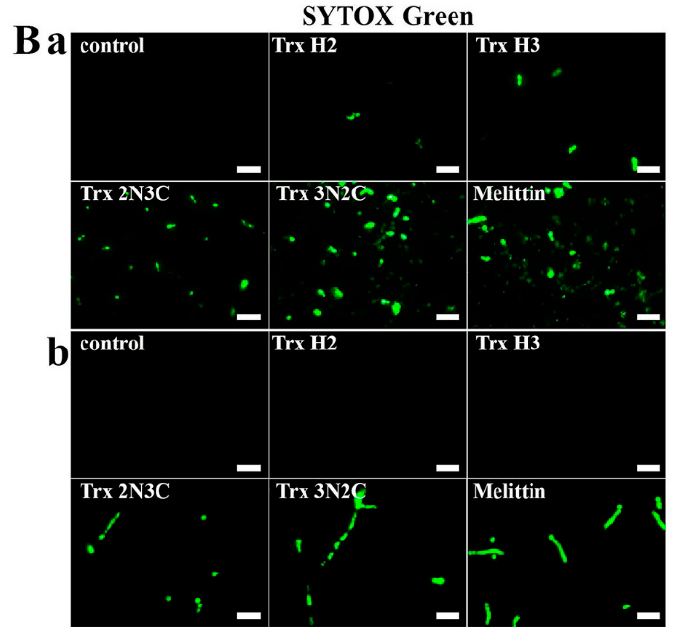
Figure 4. Effects of Trx-H2/H3/2N3C/3N2C on fungal membrane permeability. ( A ) After 1 h incubation of each protein with SYTOX Green-pretreated C. albicans cells in pH 5.2, cells were analyzed using flow cytometry. ( B ) Each protein was added to C. albicans ( a ) and C. gloeosporioides ( b ) cells pretreated with SYTOX Green, after which the cells were visualized under a fluorescence microscope. Scale bar: 10 µm.